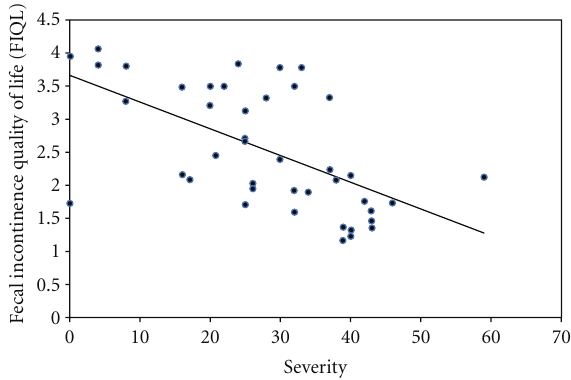
Figure 4: Quality of life as a function of severity of fecal inconti- nence in women ( P < 0 .